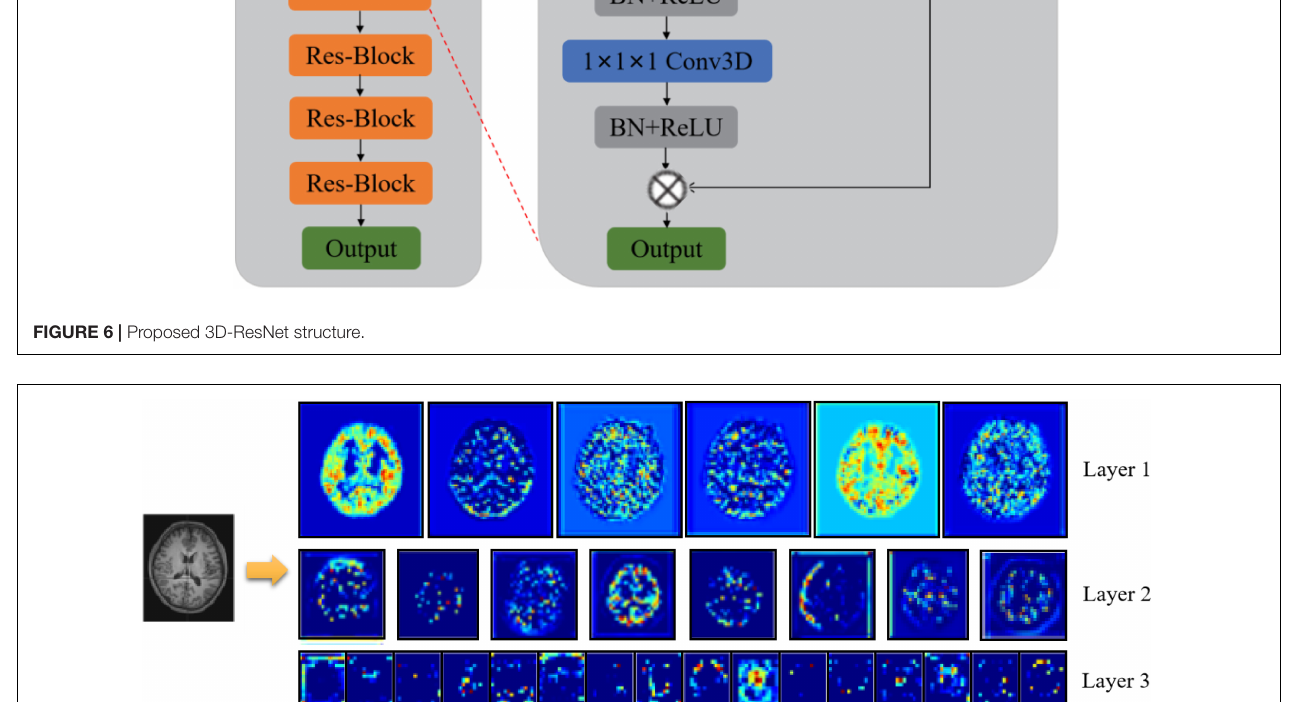
FIGURE 7 | Visualization of extracted